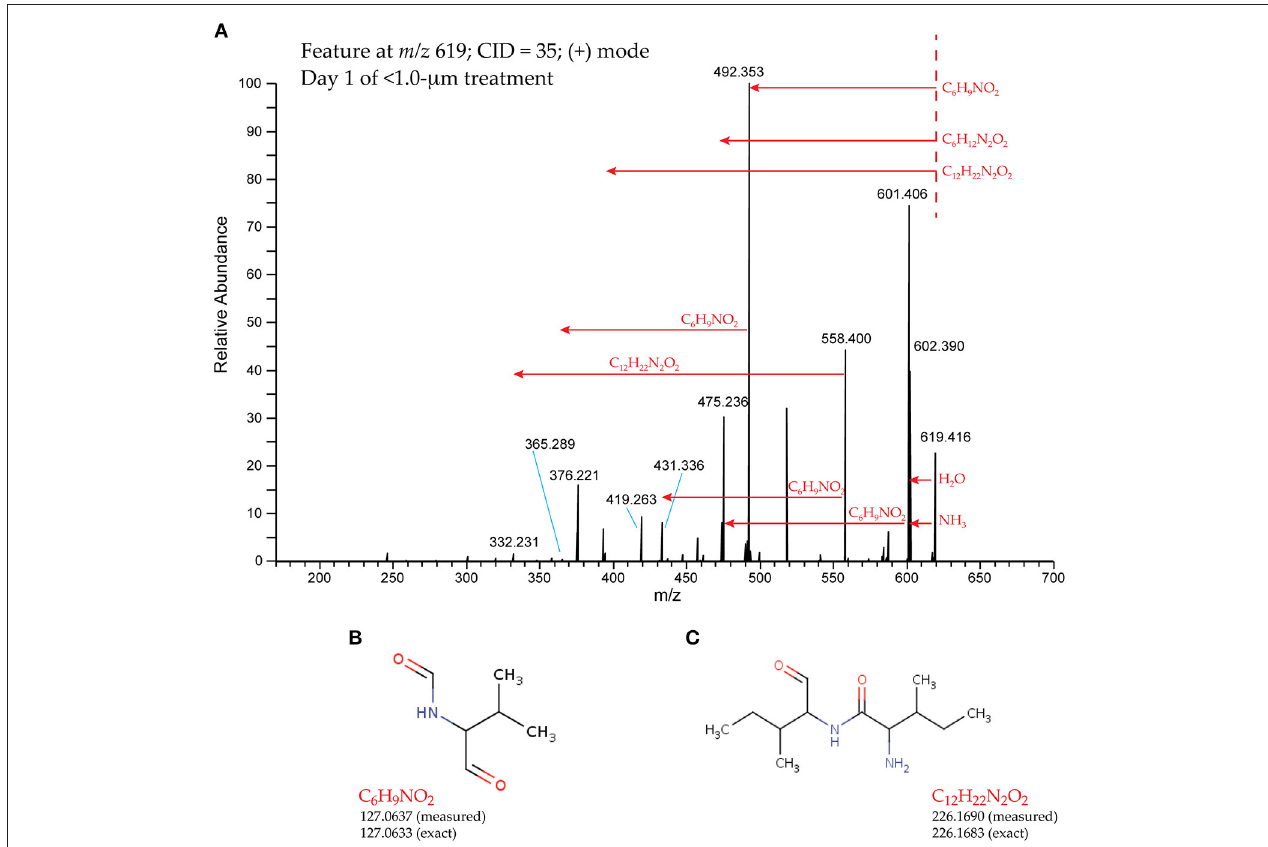
FIGURE 5 | Representative fragmentation (MS/MS) spectrum and two neutral losses. The spectrum (A) was collected from ion m/z 619.4163, isolated in the Day 1, < 1.0- µ m treatment. Dashed red line indicates position of the precursor ion; red arrows indicate neutral losses. Elemental formulas were assigned and putative structures were proposed for C 6 H 9 NO 2 (B) and C 12 H 22 N 2 O 2 (C) , based on comparison to METLIN (Tautenhahn et al., 2012).